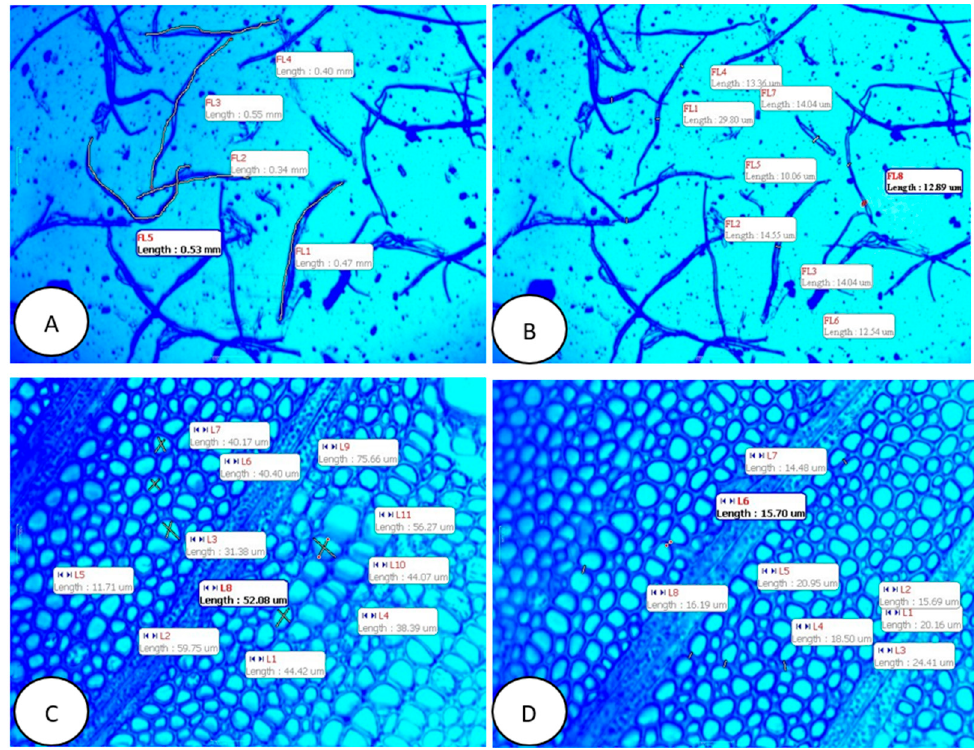
Figure 1. M. azedarach fiber images for fiber length ( A ), fiber width ( B ), lumen width ( C ) and cell wall thickness ( D ). ( A , B ) are magnified by 40 × 10, and the lumen width ( C ) and cell wall thickness ( D ) are magnified by 10 × 10.